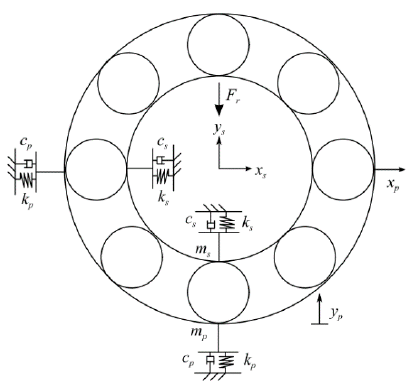
Figure 2. Vibration model of rolling element bearing.